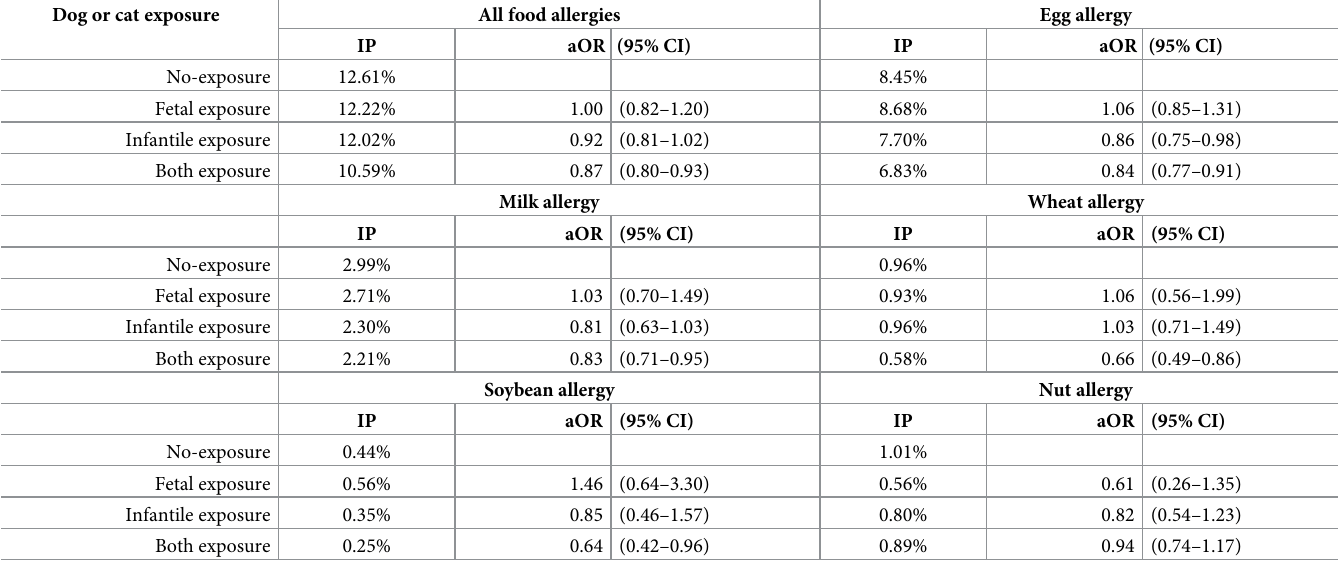
Table 2. Association between the timing of dog or cat exposure and the incidence risk of food allergies. Dog or cat